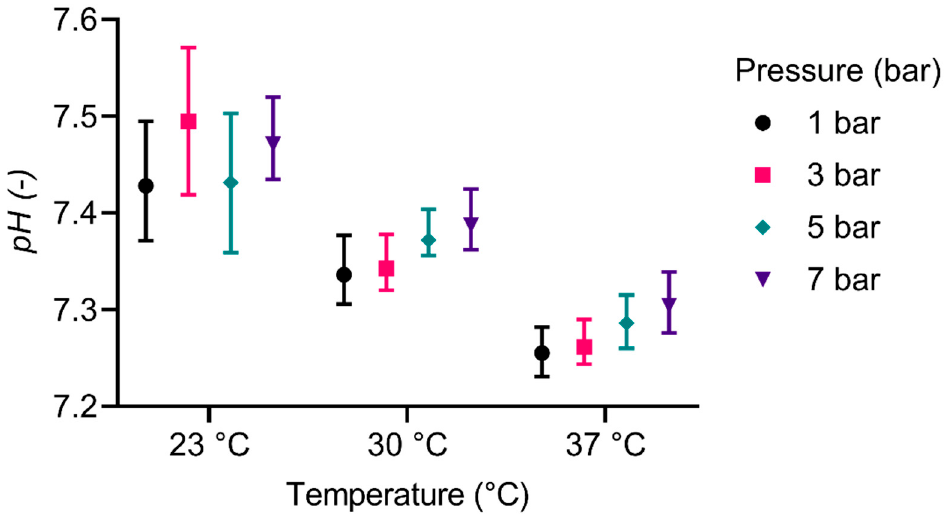
Figure 7. pH-value dependent on temperature, and pressure. The whiskers represent the highest and lowest values of the corresponding